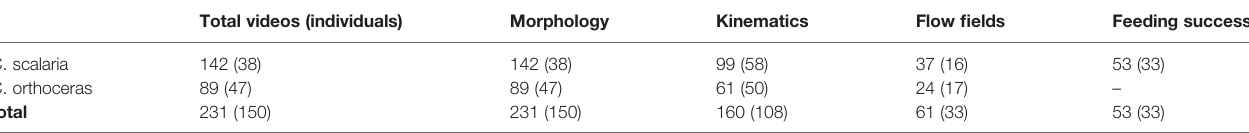
TABLE 1 | Number of videos used for the different analyses in this